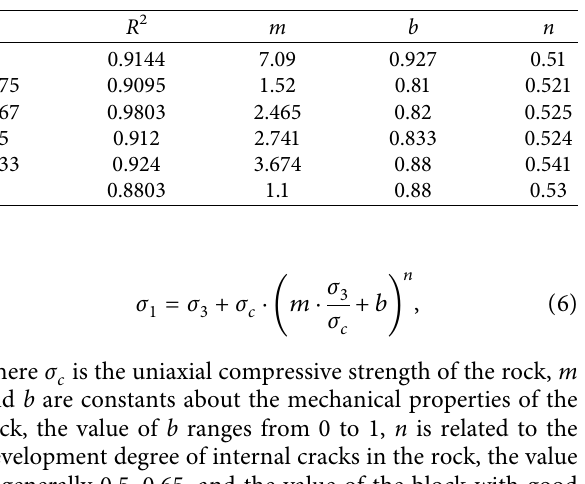
Table 4: GH-B criterion fitting parameters and R 2